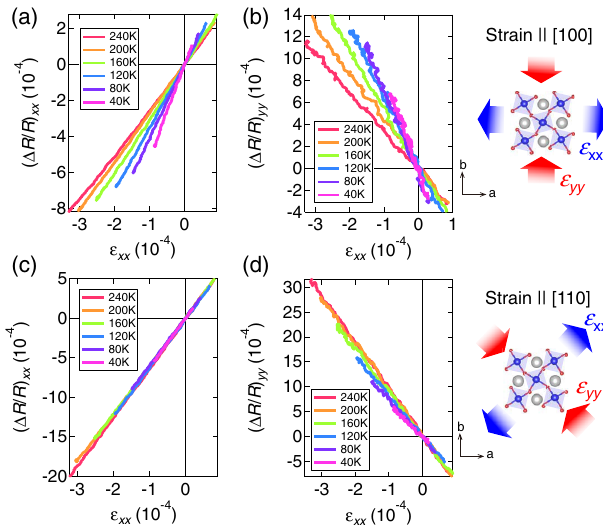
FIG. 9. Representative data of elastoresistance for Þ O ¼ 0 . 12 . (a) Longitudinal elastoresistance Sr 2 ð Ir 1 − Rh 4 with x x x ð Δ R=R Þ and (b) transverse elastoresistance ð Δ R=R Þ xx several temperatures as a function of strain ε direction x parallel to [100]. (c) Longitudinal elastoresistance ð Δ R=R Þ and (d) transverse elastoresistance ð Δ R=R Þ xx several temperatures as a function of strain ε direction x parallel to [110]. The linear response of the resistance against the strain can be seen in all the elastoresistance data.